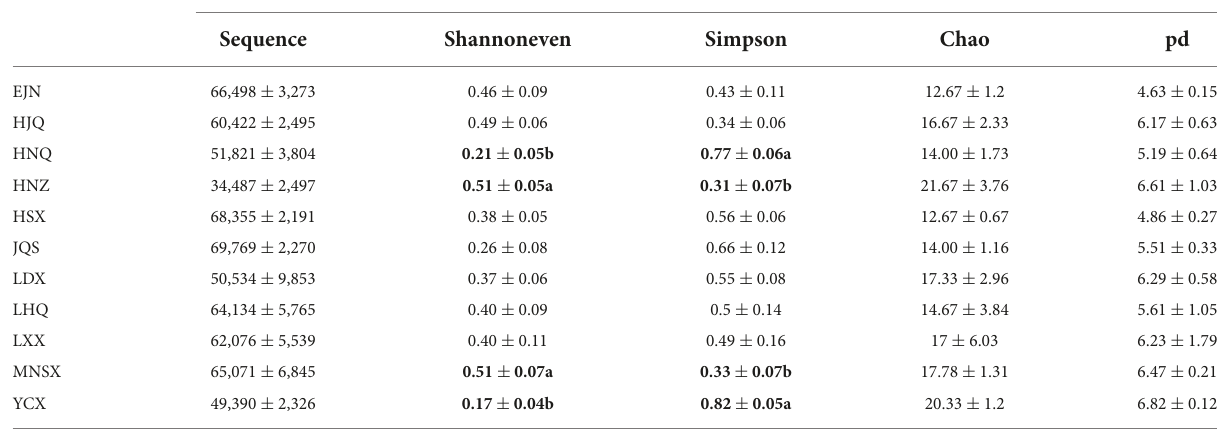
TABLE 1 Alpha diversity index of fungal community in S. alopecuroides seeds.